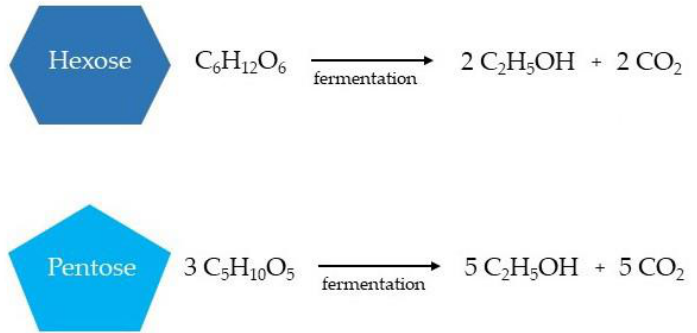
Figure 7. Simplified ethanol production from hexoses and pentoses during the fermentation stage.